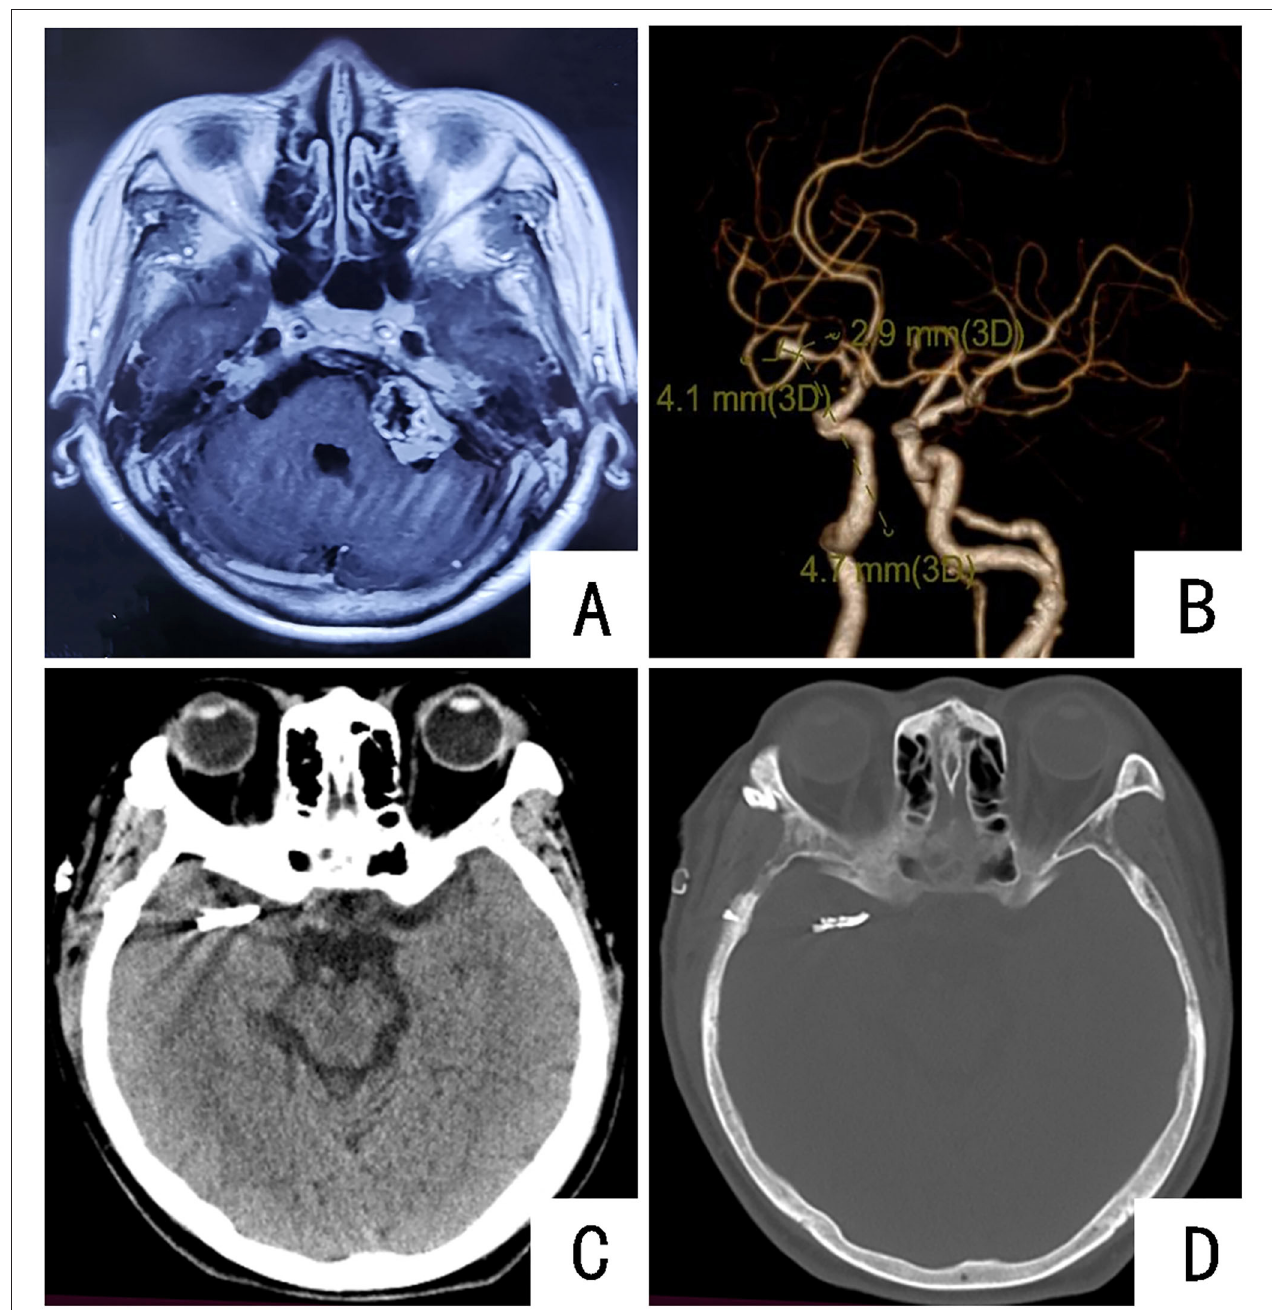
FIGURE 3 | Preoperative and postoperative imaging examinations of the patient: (A) MRI showing space-occupying lesions in the left cerebellopontine area; (B) CTA showing the right middle cerebral artery M1 aneurysm; (C,D) CT results of the head of the patient on the first day after the operation. Aneurysm clippings can be seen.